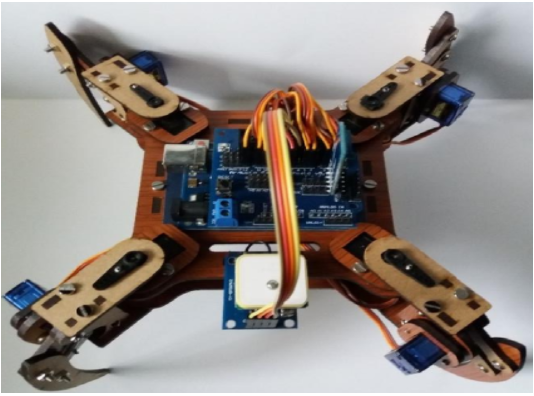
Figure 2. Quadruped vehicle in charge of collecting the greenhouse information.